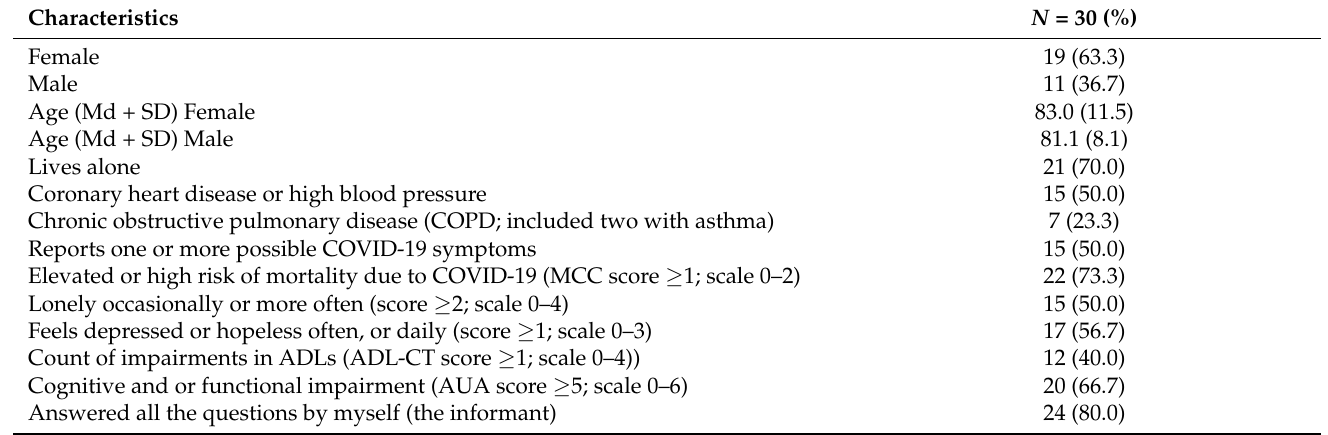
Table 1. Description of elderly homecare client characteristics as reported using the interRAI COVID-19 Vulnerability Screener ( N =